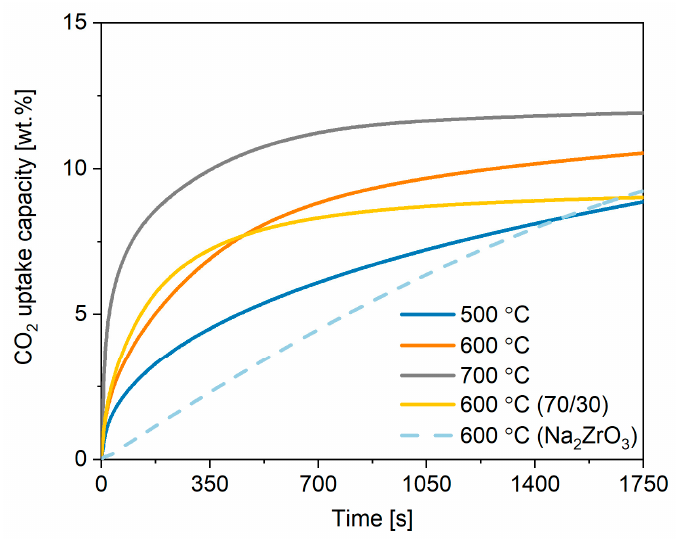
Figure 2. CO 2 adsorption curves for commercial K 2 SnO 3 under different temperatures in comparison to Na 2 ZrO 3 [27], where (70/30) stands for a mixture containing 70 wt.% K 2 SnO 3 and 30 wt.% Na 2 ZrO 3 .